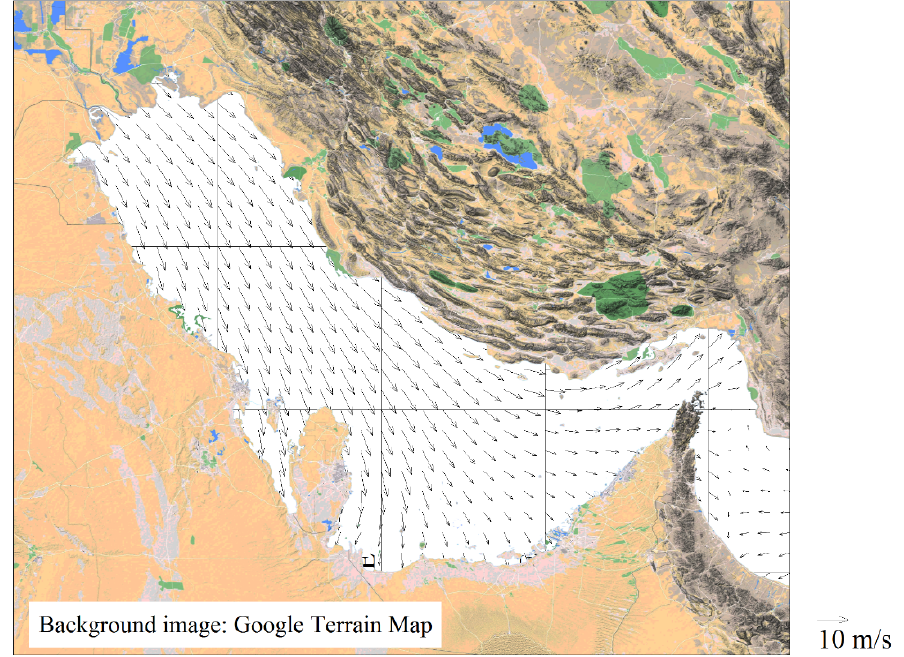
Figure 2. Wind velocity vectors over the Persian Gulf showing a typical Shamal wind event (22 January 2010).